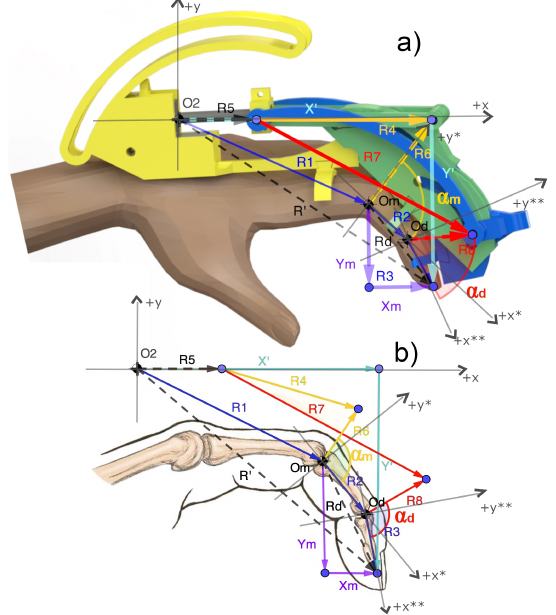
Figure 1. Figure illustrating the mechanism’s kinematic chains for the middle-distal phalange’s conjoined movement. ( a ) Shows the vectors superimposed on the mechanism’s 3D model. ( b ) Shows the vectors on the finger so the virtual centers of rotation O m and O d can be appreciated. As can be seen in this figure, there are several vector paths of interest (represented in different colors). Combinations between different vector paths produce kinematic chains that will be used to generate vector loop equations. The * and ** marks indicate local planes of reference.